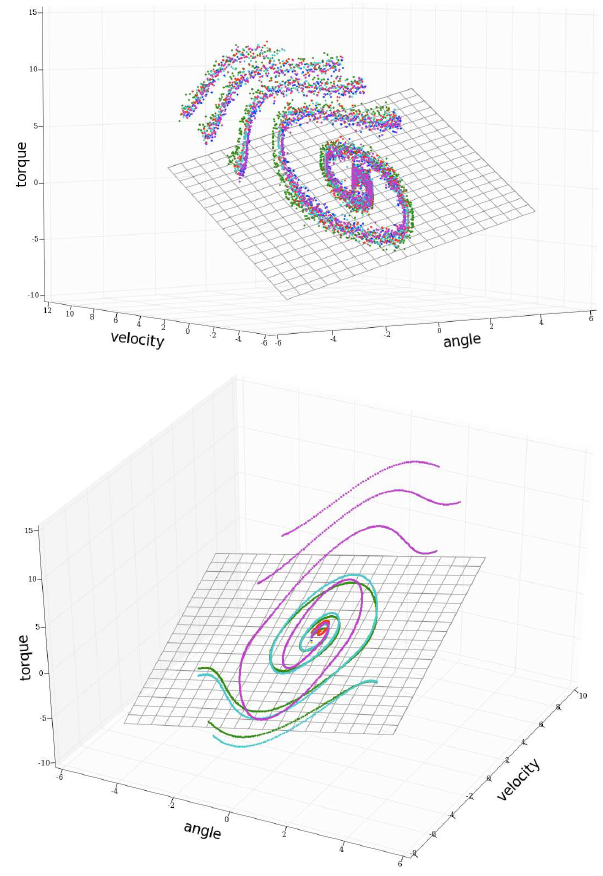
Figure 2. Illustration of the main difference between action (left) and parameter (right) exploration. Several rollouts in state-action space of a task with state x ∈ R 2 (velocity and angle axes) and action a ∈ R (torque axis) are plotted. While exploration based on action perturbation fol- lows the same trajectory over and over again (with added noise), pa- rameter exploration instead tries different and can quickly ategies find solutions that would take a long time to discover str